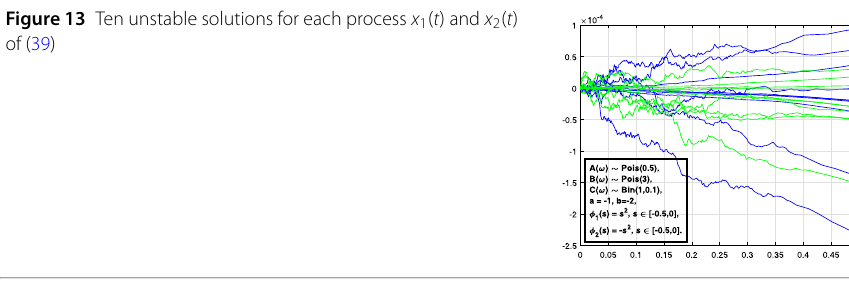
< 0, A ( ω ) is a nonnegative random variable. 4